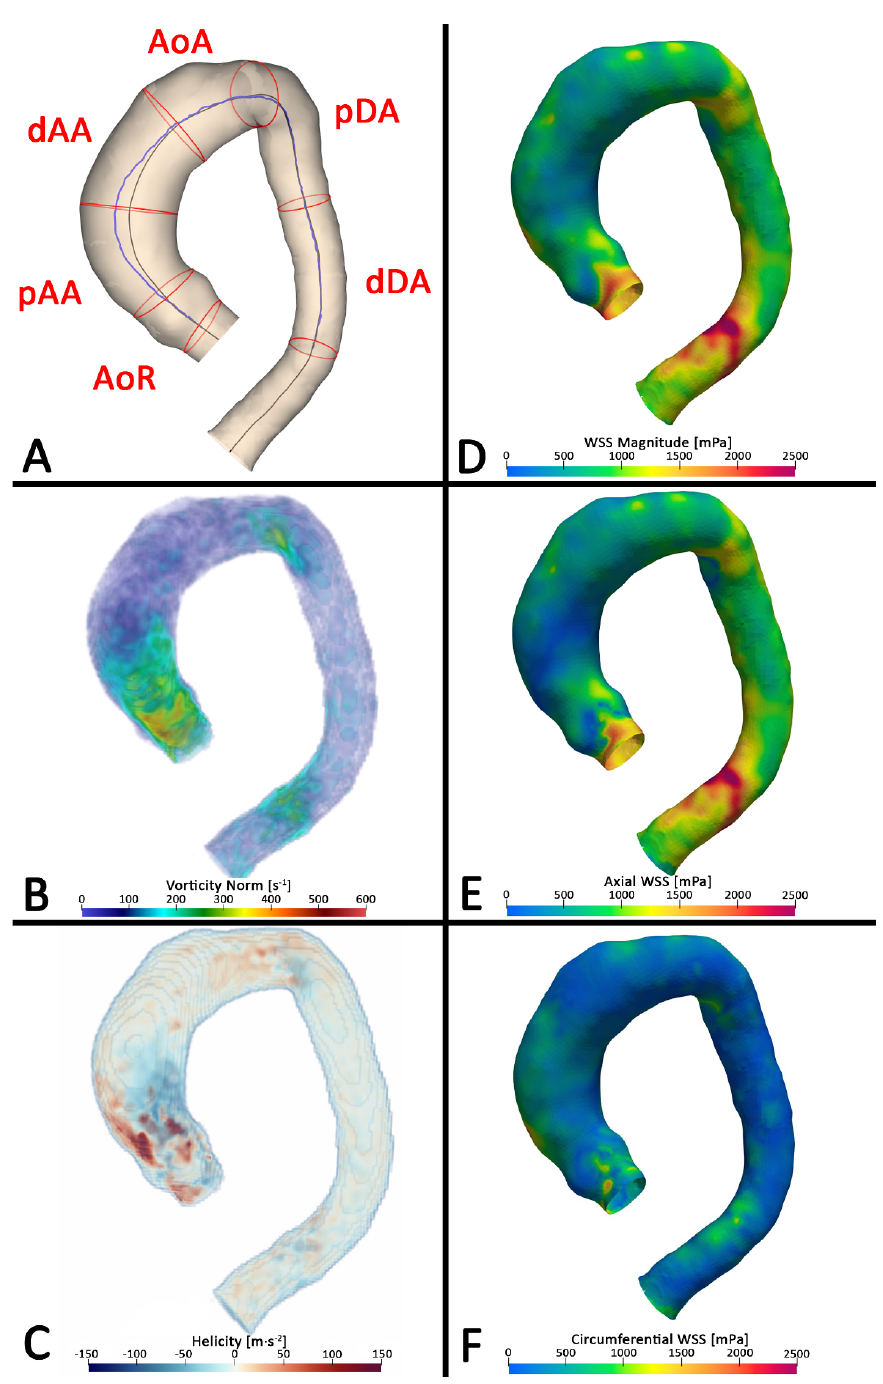
Figure 3. Aortic segments and hemodynamic parameters. Example of a patient (male, 71 years old) with an ascending aorta aneurysm with a diameter of 48 mm. ( A ) Anatomical segments with centerline (black color) and flow displacement line (blue color). ( B ) Vorticity norm. ( C ) Absolute helicity. Positive and negative magnitudes indicate a clockwise and anti-clockwise rotation, respectively. ( D ) Wall shear stress magnitude. ( E ) Axial wall shear stress. ( F ) Circumferential wall shear stress. Abbreviations: AoR—aortic root, pAA—proximal ascending aorta, dAA—distal